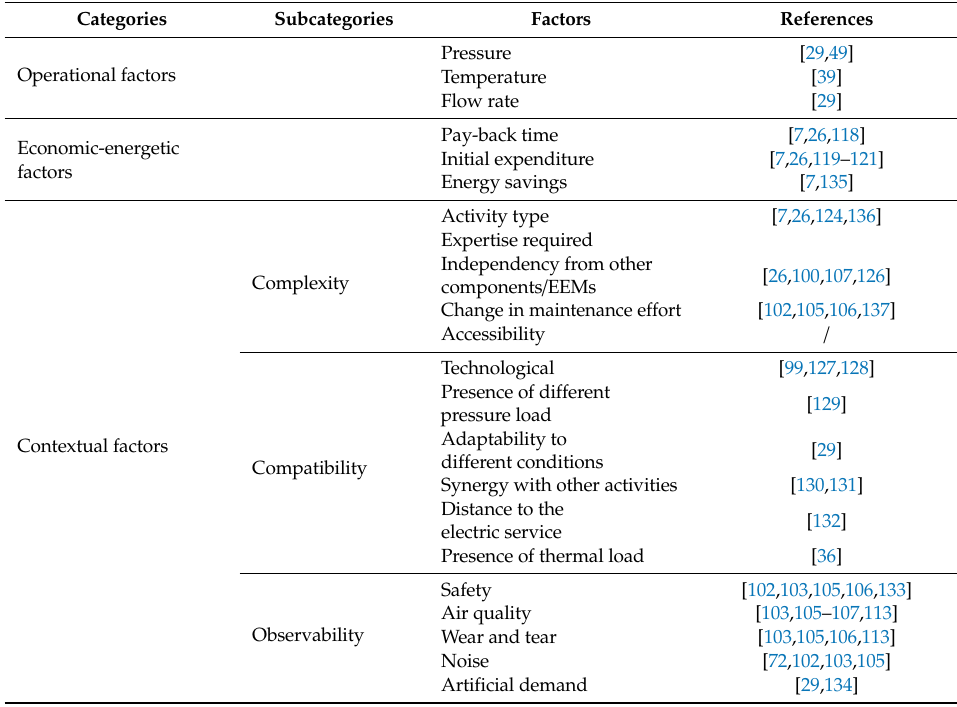
Table 3. Categories, subcategories, and factors of the new